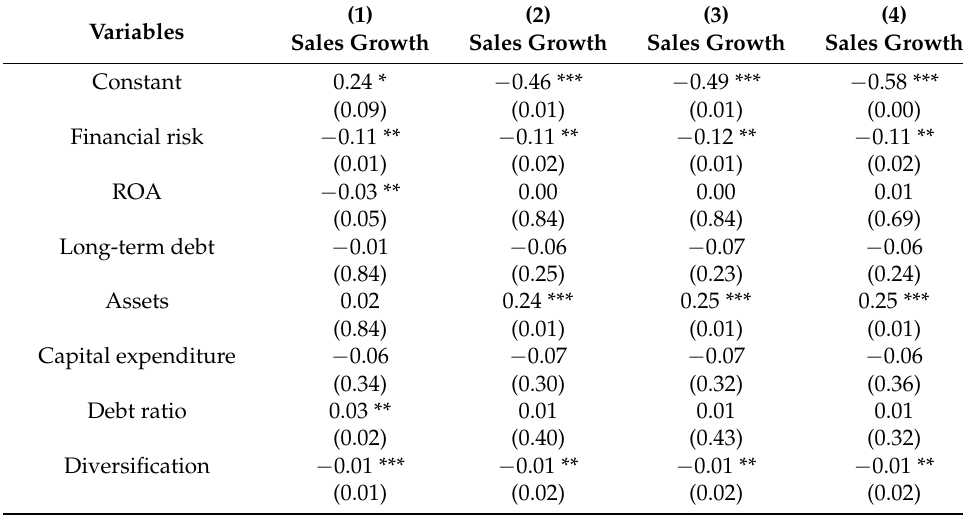
Table 4. Robustness check #2—Probit regression with dependent variable median